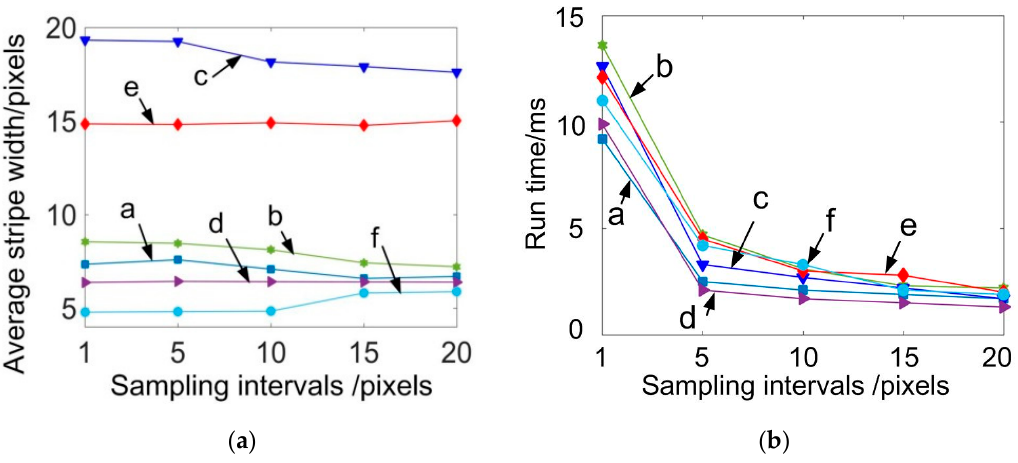
Figure 11. Influence of sampling intervals on the ( a ) average stripe width and the ( b ) run time.